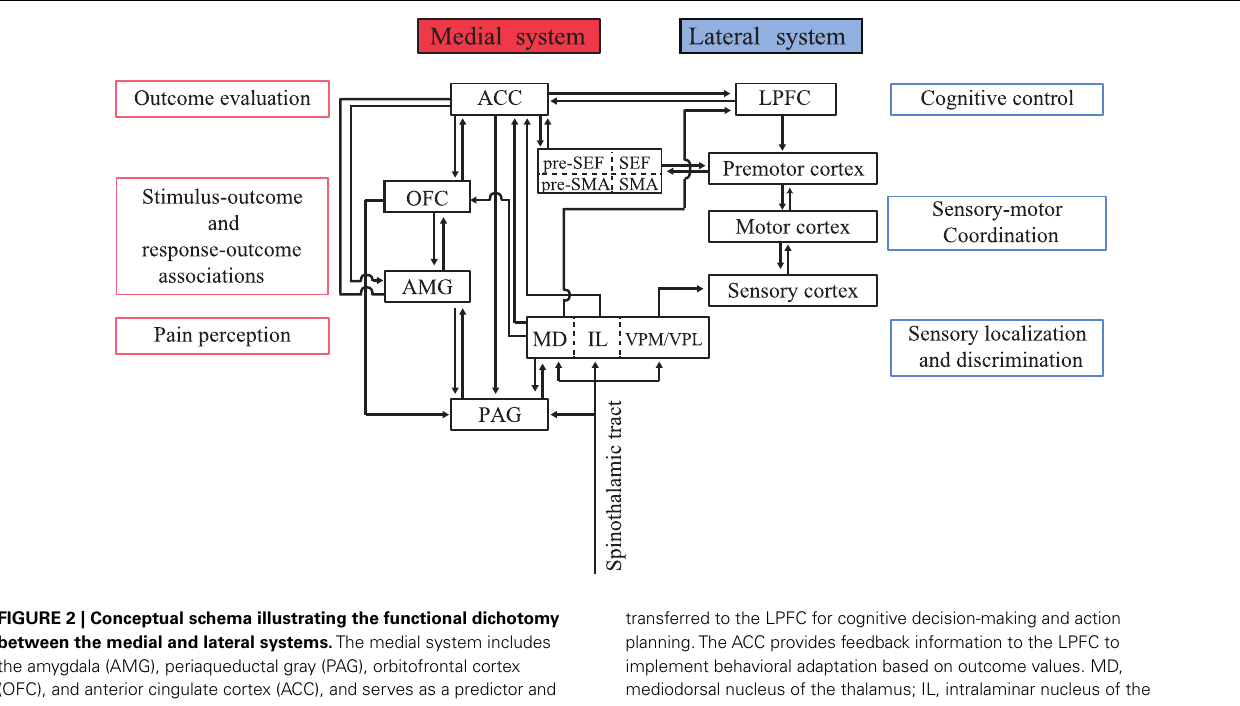
FIGURE 2 | Conceptual schema illustrating the functional dichotomy between the medial and lateral systems. The medial system includes the amygdala (AMG), periaqueductal gray (PAG), orbitofrontal cortex (OFC), and anterior cingulate cortex (ACC), and serves as a predictor and evaluator of behavioral outcomes.The lateral system receives multimodal sensory inputs and processes the signals to obtain physical information regarding the environment. Sensory information is